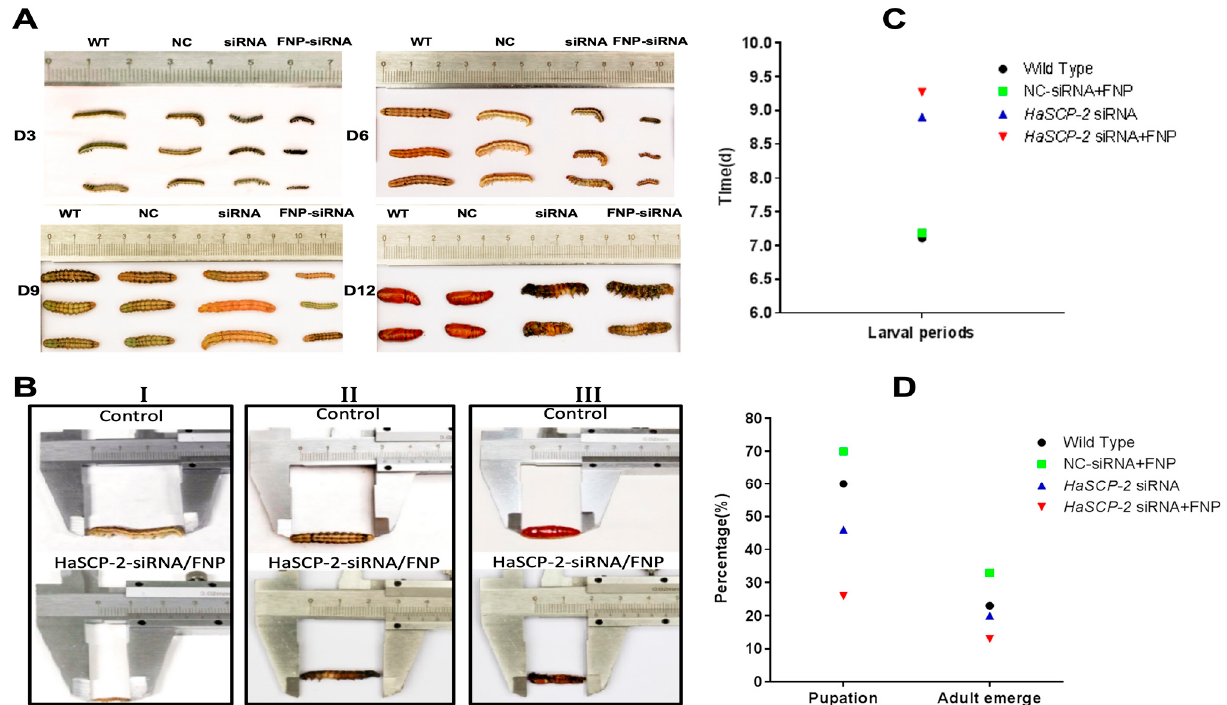
Figure 8. Effect of FNP-RNAi on growth and development. ( A ) 3, 6, 9, and 12 days after FNP- HaSCP-2 siRNA oral feeding (WT: wild type; NC: FNP-negative control siRNA group; siRNA: HaSCP-2 siRNA group; FNP-siRNA: FNP + HaSCP-2 siRNA group). ( B ) Abnormal development of larvae and pupae resulted from FNP- HaSCP-2 siRNA treatment (( I ) Day 3 post siRNA ingestion; ( II ) Day 8 post siRNA ingestion; ( III ) Day 12 post siRNA ingestion). ( C ) Larval periods. ( D ) Pupation and adult emergence.